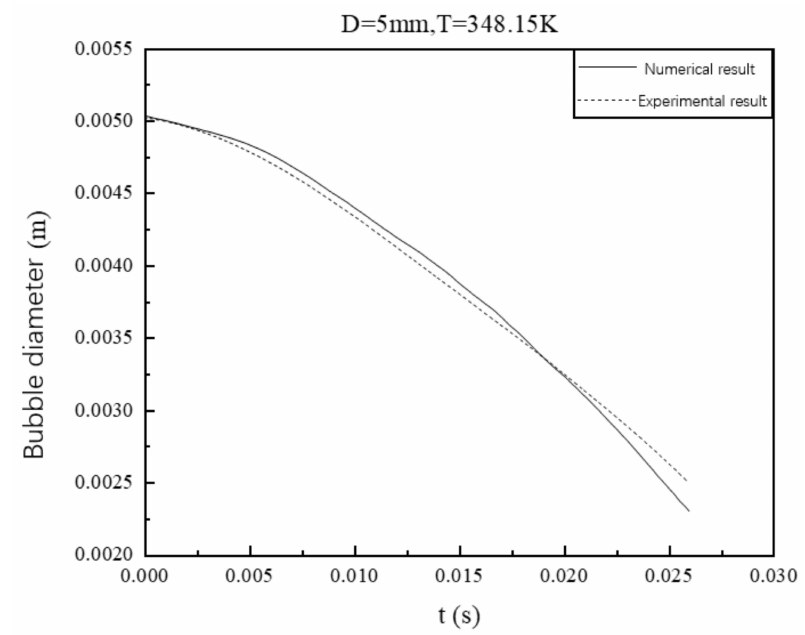
Figure 3. Comparison of bubble diameter with fitting formula and Kim’s